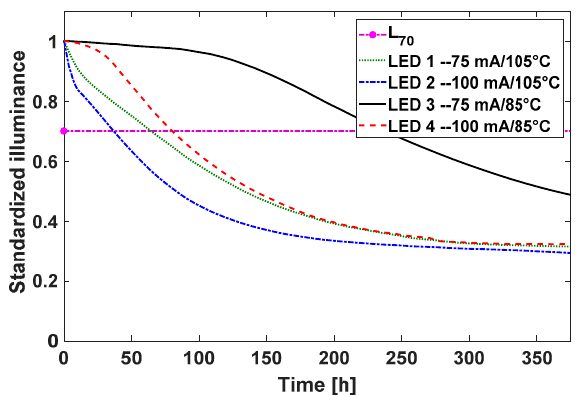
Figure 18. Variation of the light intensity over time for each constellation.